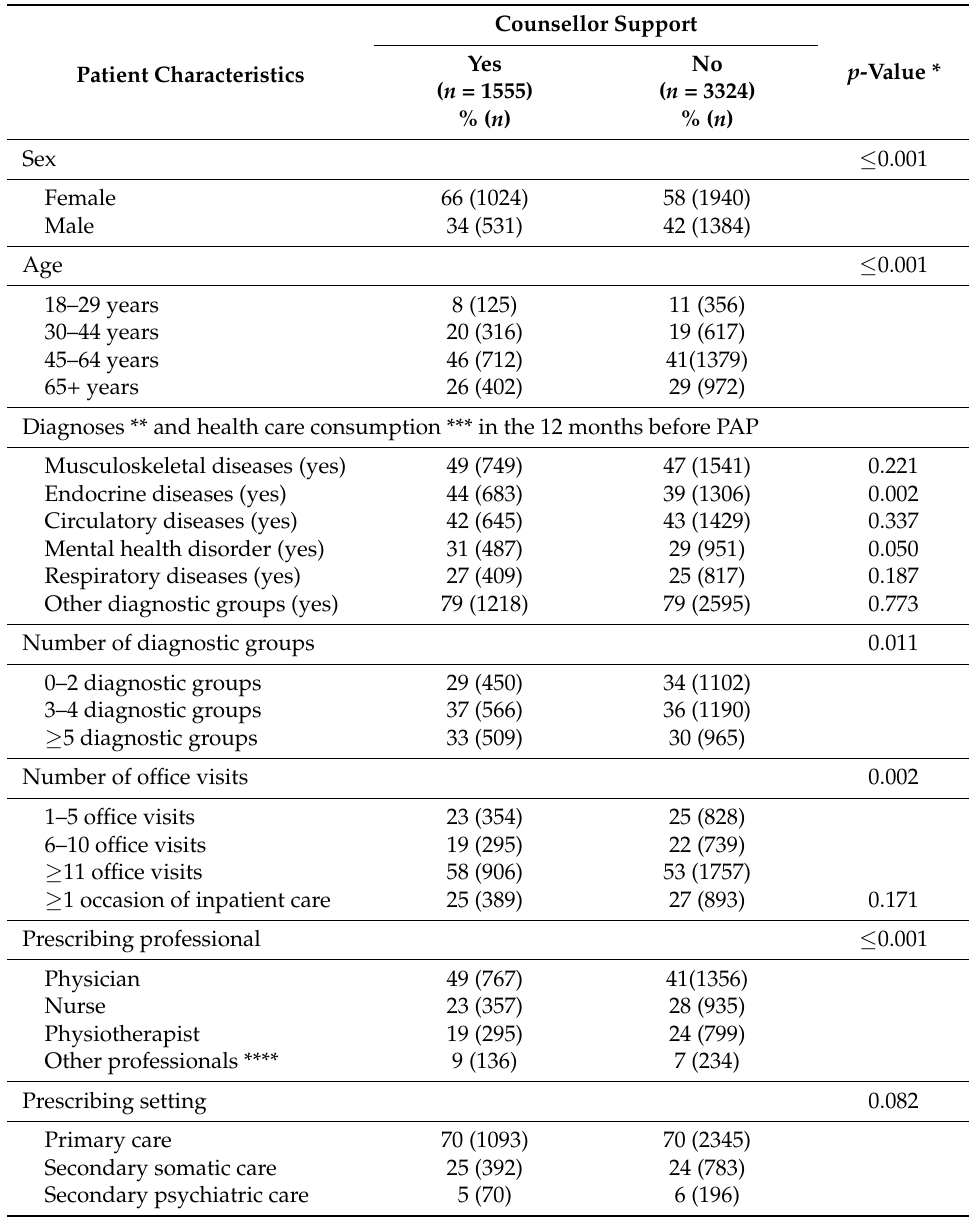
Table 3. Differences in characteristics between patients using versus not using counsellor support after receiving a PAP ( n =